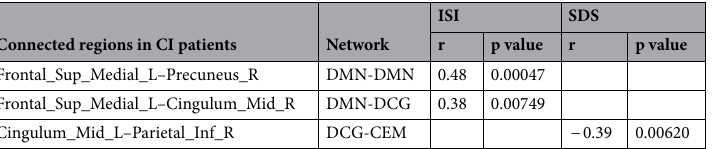
Table 4. Associations of FC features and clinical characteristics in CI patients. CI chronic insomnia, ISI insomnia severity index, SDS self-rating depression scale; for other abbreviations please see Table